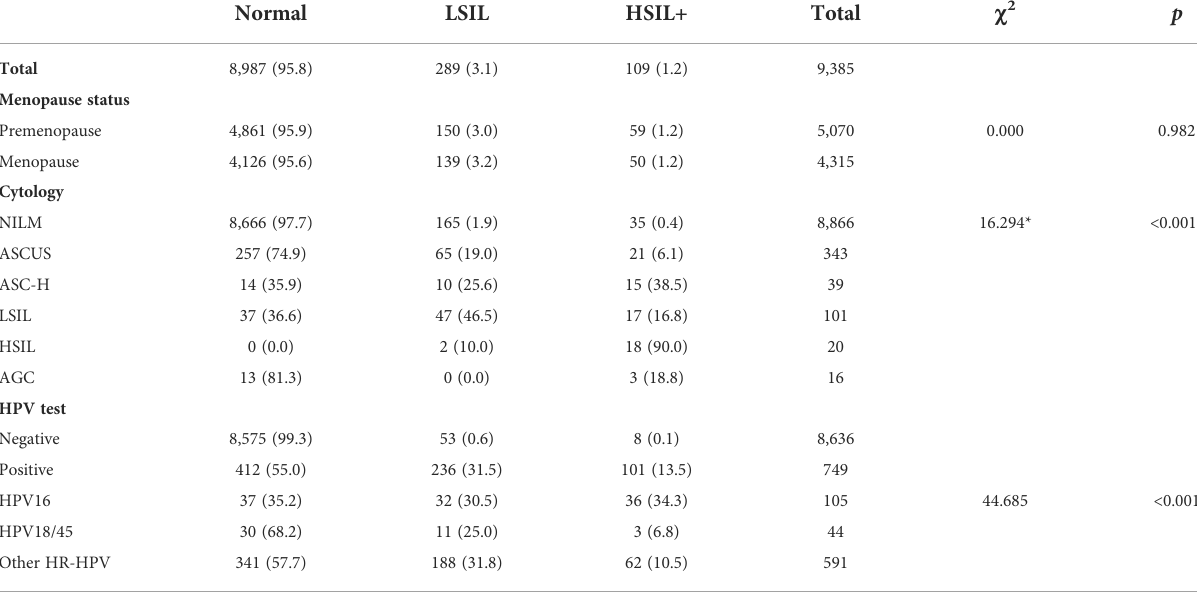
TABLE 2 Distribution of histological diagnosis results strati fi ed by menopause status, cytology, HPV, and genotyping test results (N [%]).